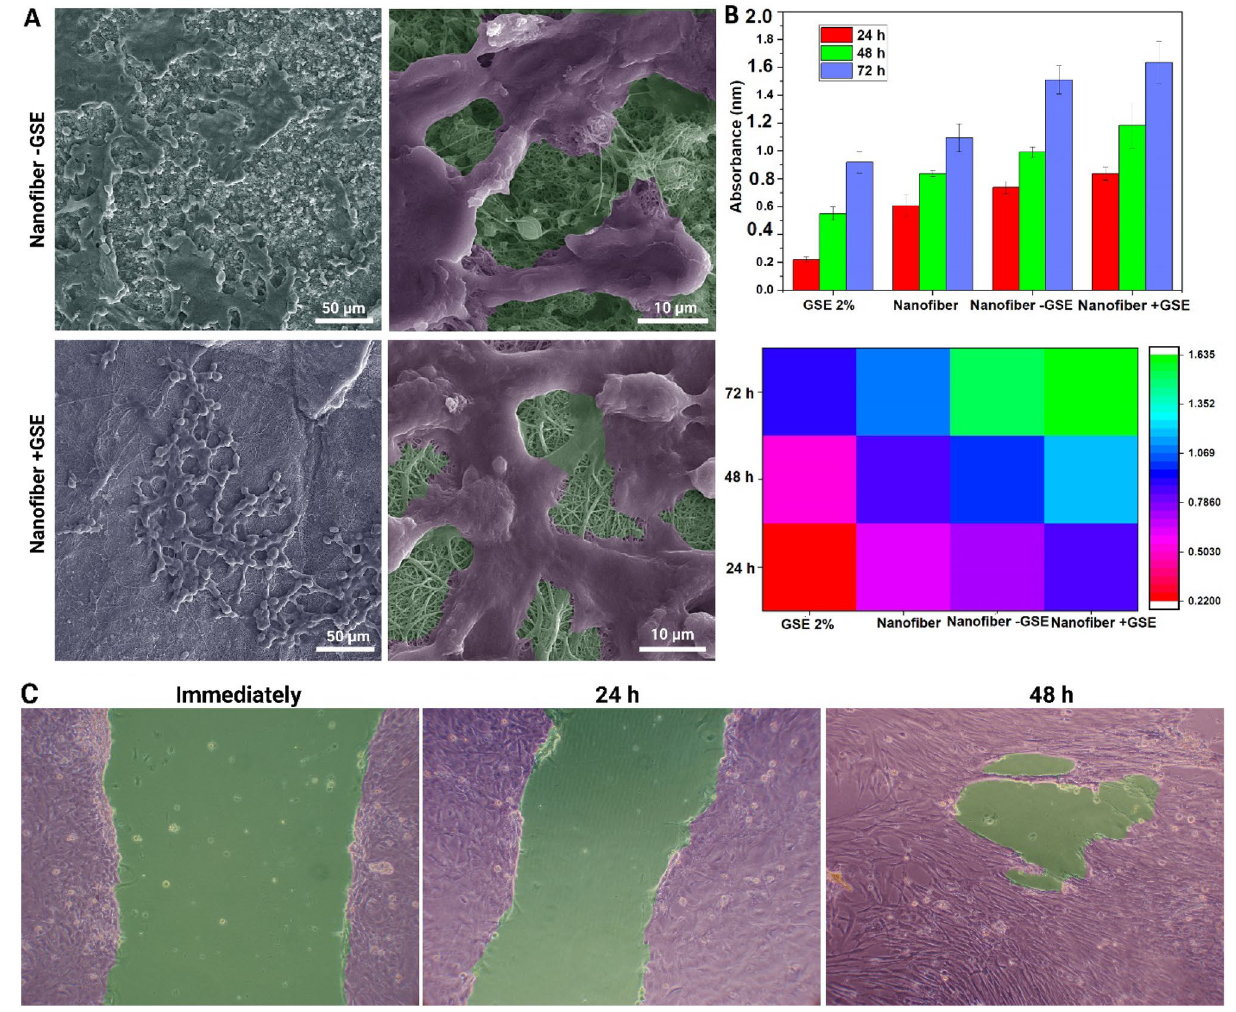
Figure 6. ( A ) FE-SEM image of HDF stem cells proliferation on the nanofibrous mat with and without GSE. The cells were artificially colored to be more distinguishable in the image. ( B ) Bar graph and heatmap related to the results of the MTT assay. ( C ) In vitro cell migration assay at different times. The images were colored to show the different